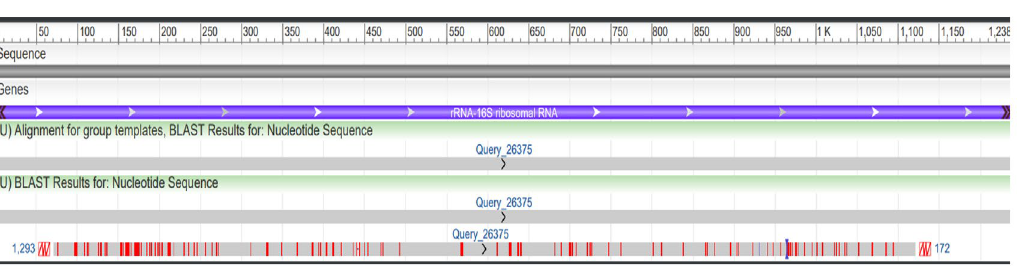
Fig. 3. Oceanobacillus iheyensis gene for 16S rRNA, partial sequence, strain: RP- L-1 1,071 bp linear DNA. species,